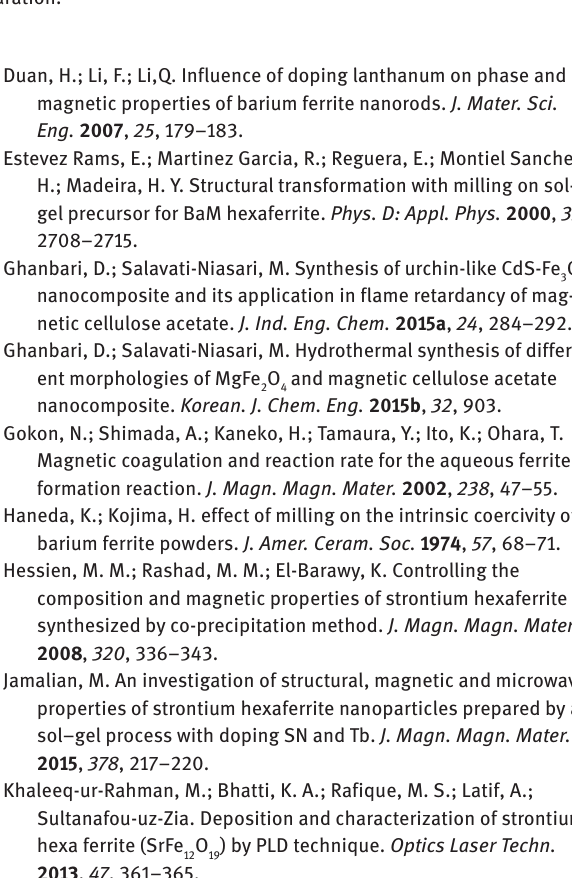
Figure 17: (A) Schematic of ferrite preparation (B) nanocomposite